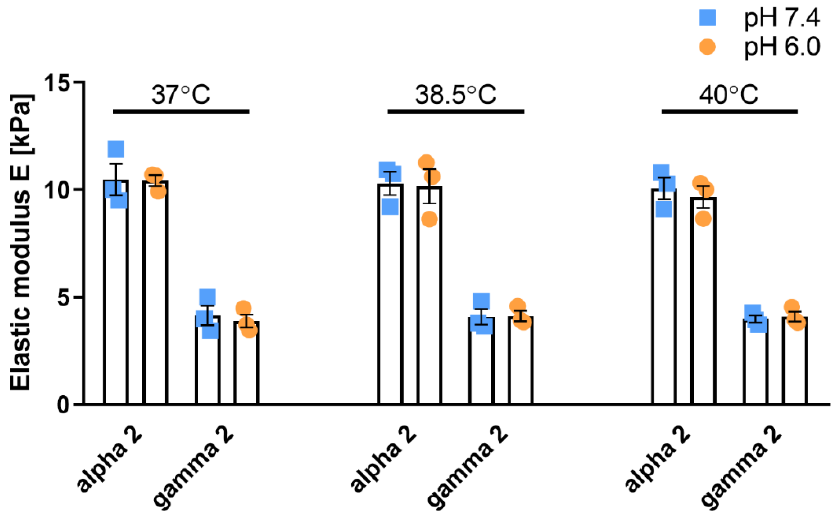
Figure 2. PeptiGels maintained stiffness stability in increased temperature and acidic pH. Average elastic modulus across 0.1–10% strain calculated as E = 2 × G’ (1 + υ ) where, υ = Poisson’s ratio of 0.5. Histogram bars represent the mean ± SEM, and dots represent average value for each experimental replicate n = 3. No statistically significant difference between 37 °C, pH 7.4; 37 °C, pH 6.0; 38.5 °C, pH 7.4; 38.5 °C, pH 6.0; 40 °C, pH 7.4; and 40 °C, pH 6.0 for Alpha 2 and Gamma 2, respectively, tested with ANOVA with Dunnett’s post hoc test.